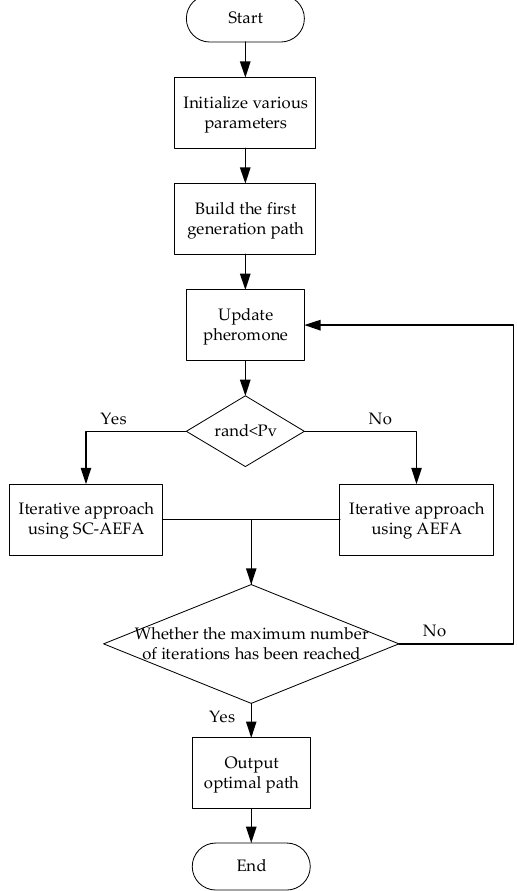
Figure 5. The flow chart of the algorithm.